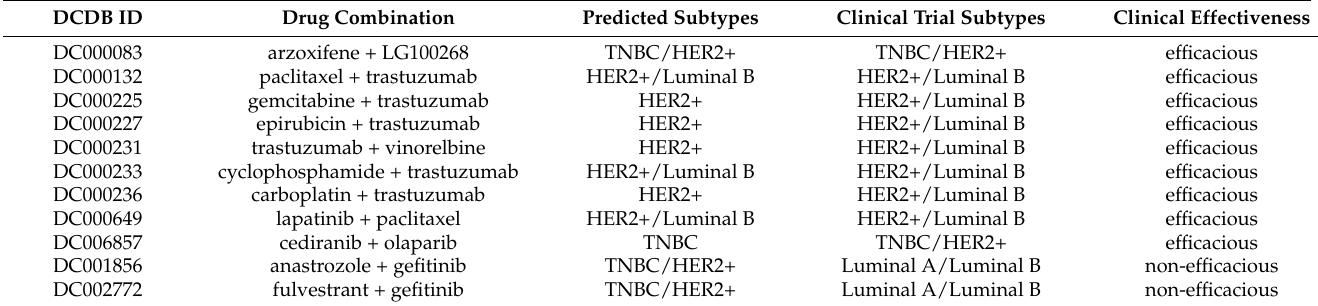
Table 4. Actual and predictive activity of BC drugs (consistent).